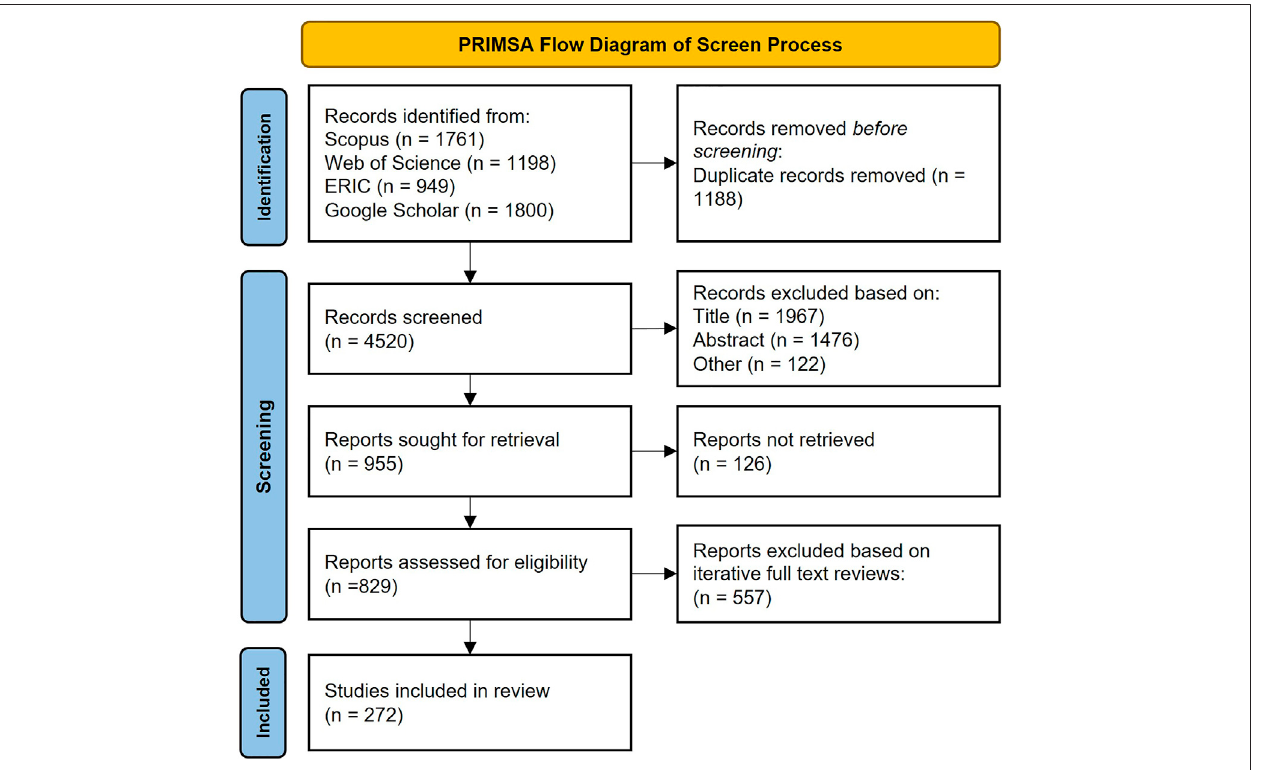
FIGURE 1 | PRISMA Flow Diagram Illustrating the Screening Process for this Study.